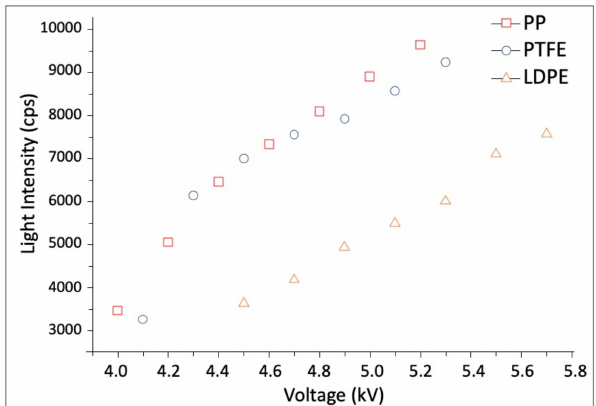
Figure 2. The EL scatter curves polymers vs. voltage. Reprinted with permission from ref. [21]. Copyright 2006